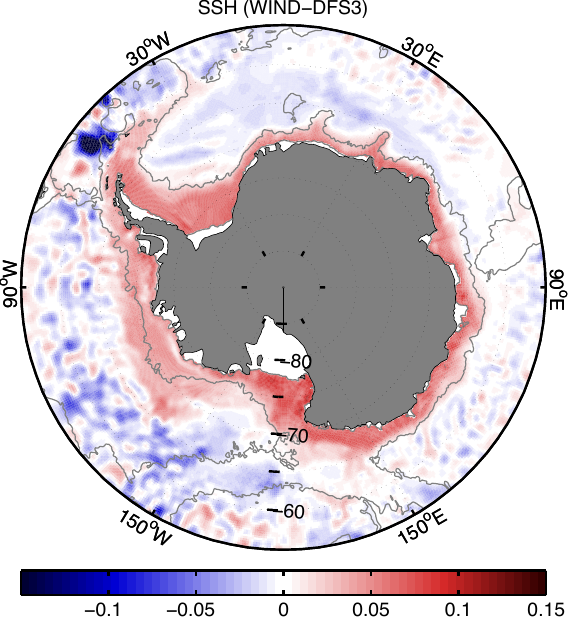
Fig. 14. SSH difference (in m) between WIND and REF. A red area means a higher SSH in WIND. Grey line is the 3500m bathymetry